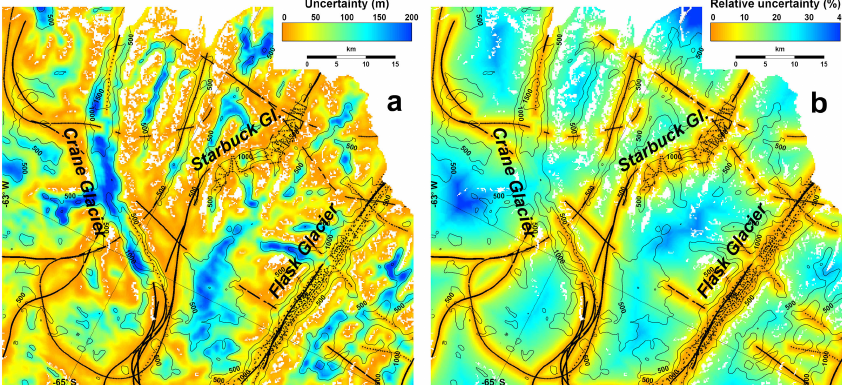
Figure 7. (a) Absolute, and (b) relative ice thickness uncertainty maps for a region around Crane/Starbuck/Flask Glacier (Fig. 1). OIB flight lines are indicated. Contours (500m interval) refer to ice thickness.